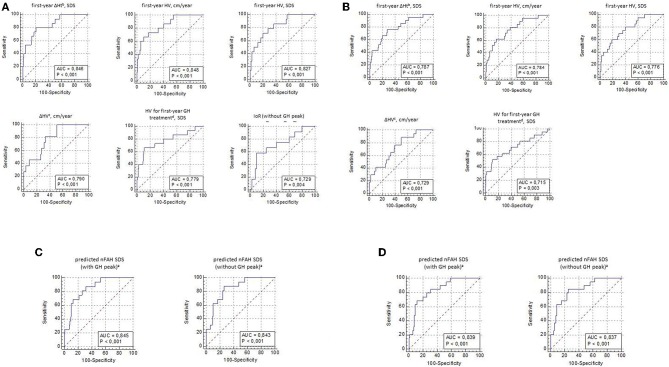
(A) ROC curve analysis for first-year response and responsiveness parameters, with its sensitivity and specificity to predict total ΔHt SDSa <1(CA). CA, SDS calculated at chronological age; SDS, standard deviation score; cm, centimeter; HV, height velocity; GH, growth hormone; IoR, index of responsiveness; AUC, area under the ROC curve; again in height SDS f rom start of GH treatment until near final adult height; bgain in height SOS after first-year GH treatment; cHV during first-year GH treatment minus HV during pretreatment year; dgrowth targets for first-year GH response by Ranke et al. (B) ROC curve analysis for first-year response and responsiveness parameters, with its sensitivity and specificity to predict total ΔHt SDSa <1(A21). A21, SDS calculated at age 21years; SDS, standard deviation score; cm, centimeter; HV, height velocity; GH, growth hormone; AUC, area under the ROC curve; again in height SDS f rom start of GH treatment until near final adult height; bgain in height SDS after first-year GH treatment; cHV during first-year GH treatment minus HV during pretreatment year; dgrowth targets for first-year GH response by Ranke et al. (C) ROC curve analysis for predicted nFAH after first-year GH treatmenta, with its sensitivity and specificity to predict nFAH SDS <−2 (Prader, CA). nFAH, near final adult height; GH, growth hormone; SDS, standard deviation score; CA, SDS calculated at chronological age; AUC, area under the ROC-curve; aprediction model f or nFAH after first-year GH treatment by Ranke et al. (D) ROC curve analysis for predicted nFAH after first-year GH treatmenta, with its sensitivity and specificity to predict nFAH SDS <−2 (Prader, A21). nFAH, near final adult height; GH, growth hormone; SDS, standard deviation score; A21, SDS calculated at age 21 years; AUC, area under the ROC-curve; aprediction model f or nFAH after first-year GH treatment by Ranke et al.